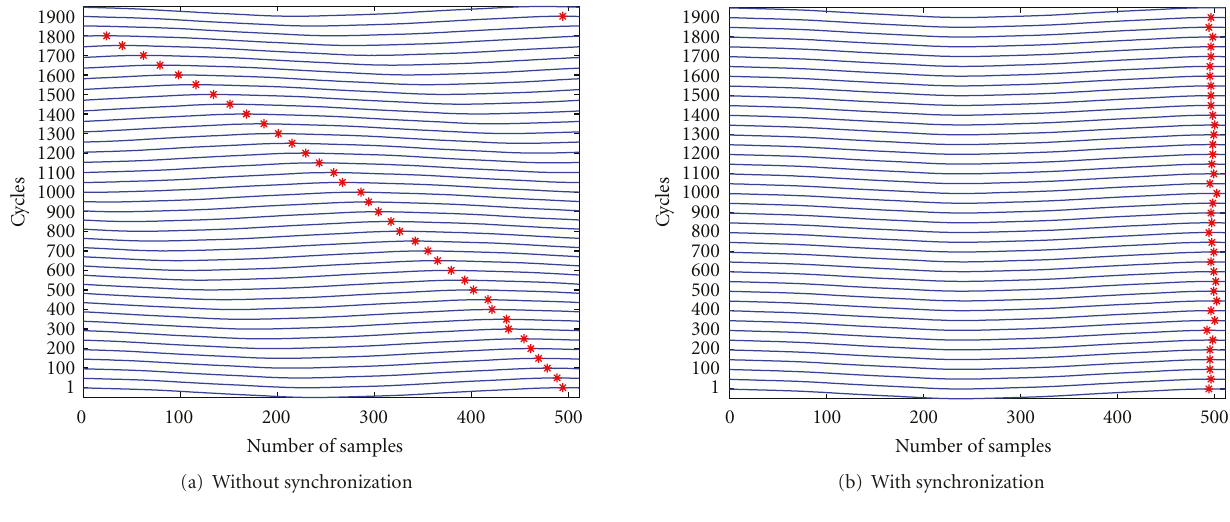
Figure 10: Plot of 1950 cycles of